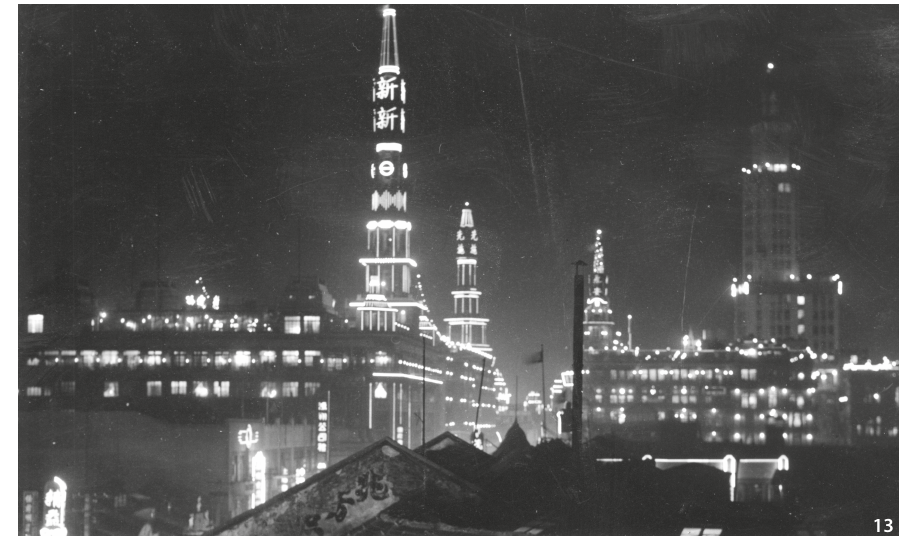
Figure 13 Night view of the Shang- hai department stores, 1937. Claude Berruyer photographer (Source: Virtual